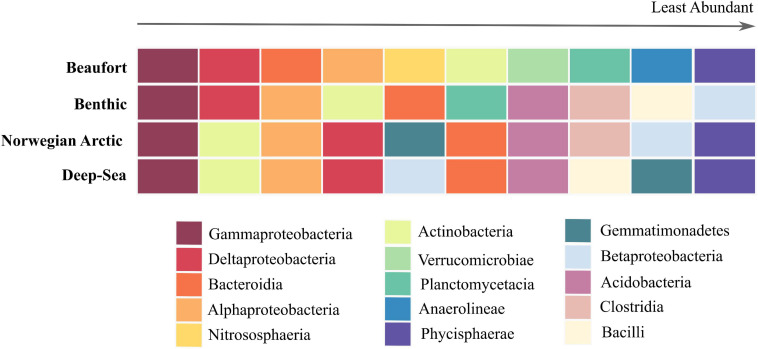
Top 10 abundant prokaryotes at class level exhibited in marine sediments. The colored grid above is arranged with surface sediment microbiomes on the y-axis, Beaufort, global benthic, Norwegian Arctic, and deep-sea (Zinger et al., 2011; Bienhold et al., 2016). The x-axis represents the rank from the most abundant taxa on the left to the least abundant taxa on the right exhibited by these microbiomes. The colors represent the class-level taxonomy of these prokaryotes.